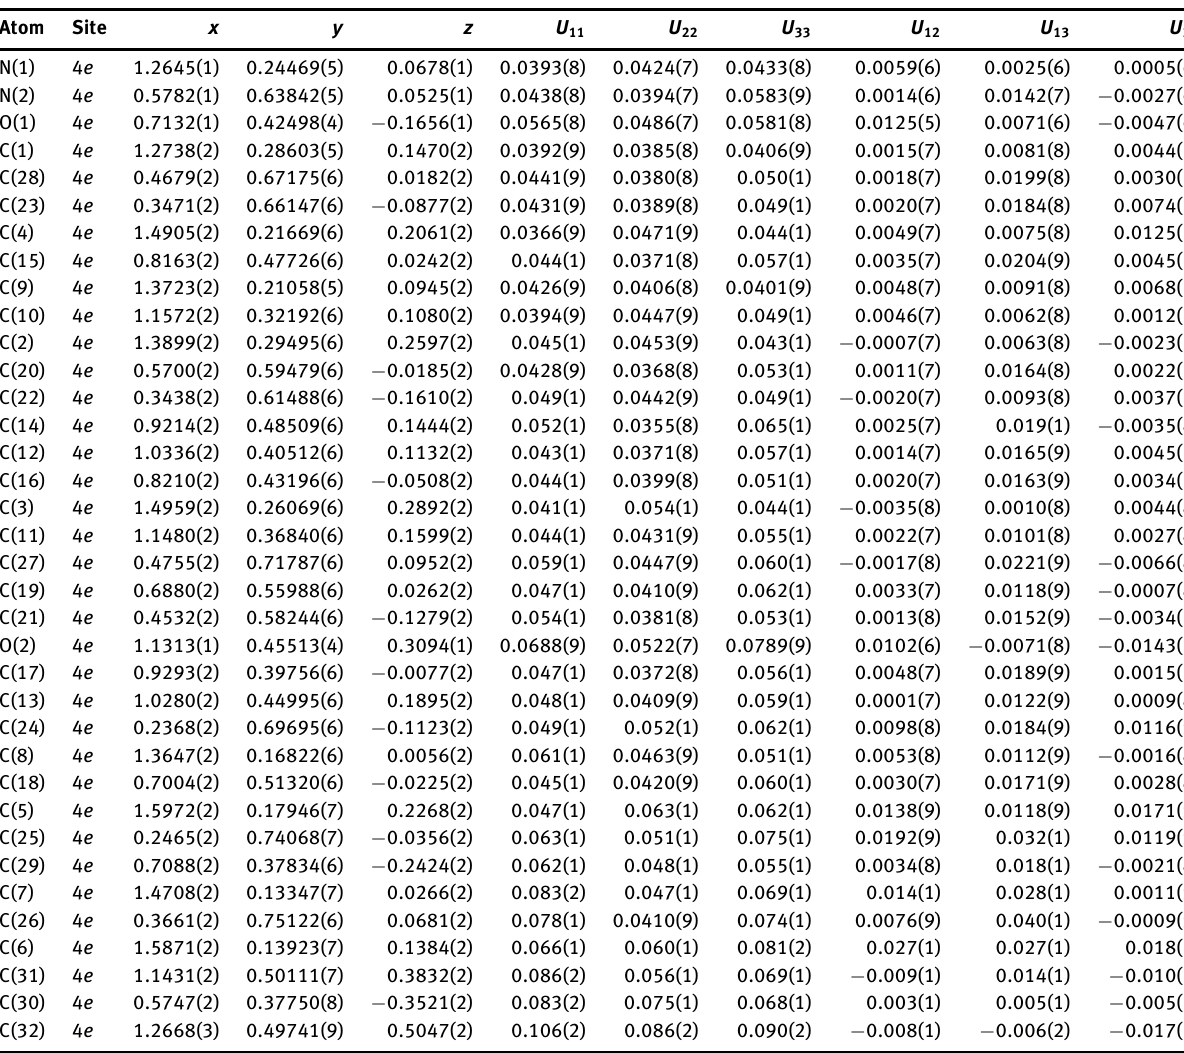
Table 3: Atomic displacement parameters (Å 2